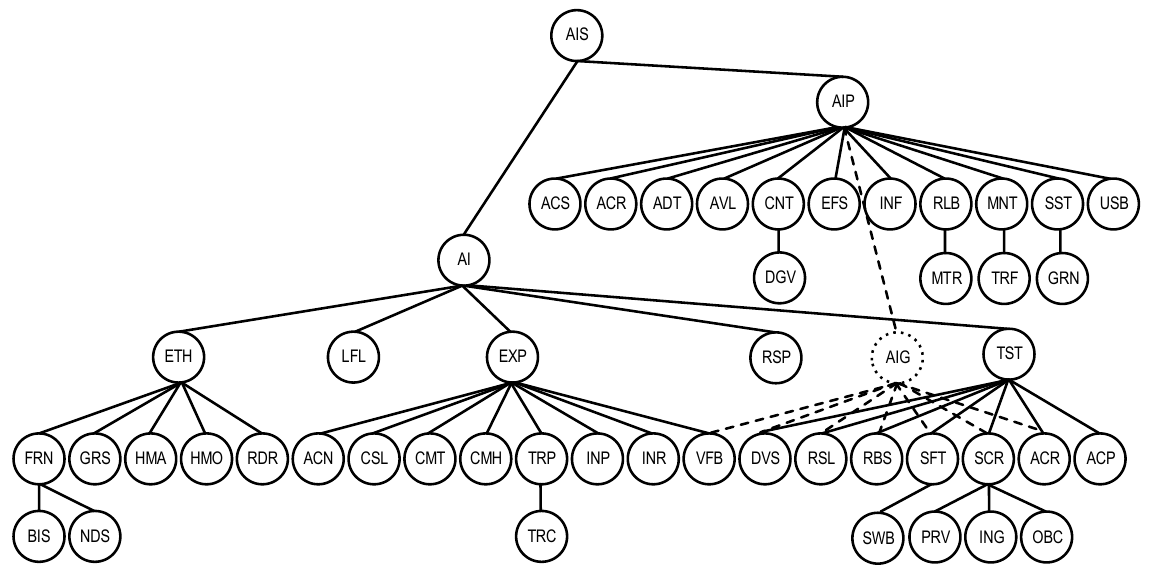
Figure 6. The graph representation of the AI system quality model 𝑄𝑆 𝐶ℎ𝐴𝐼𝑆 .